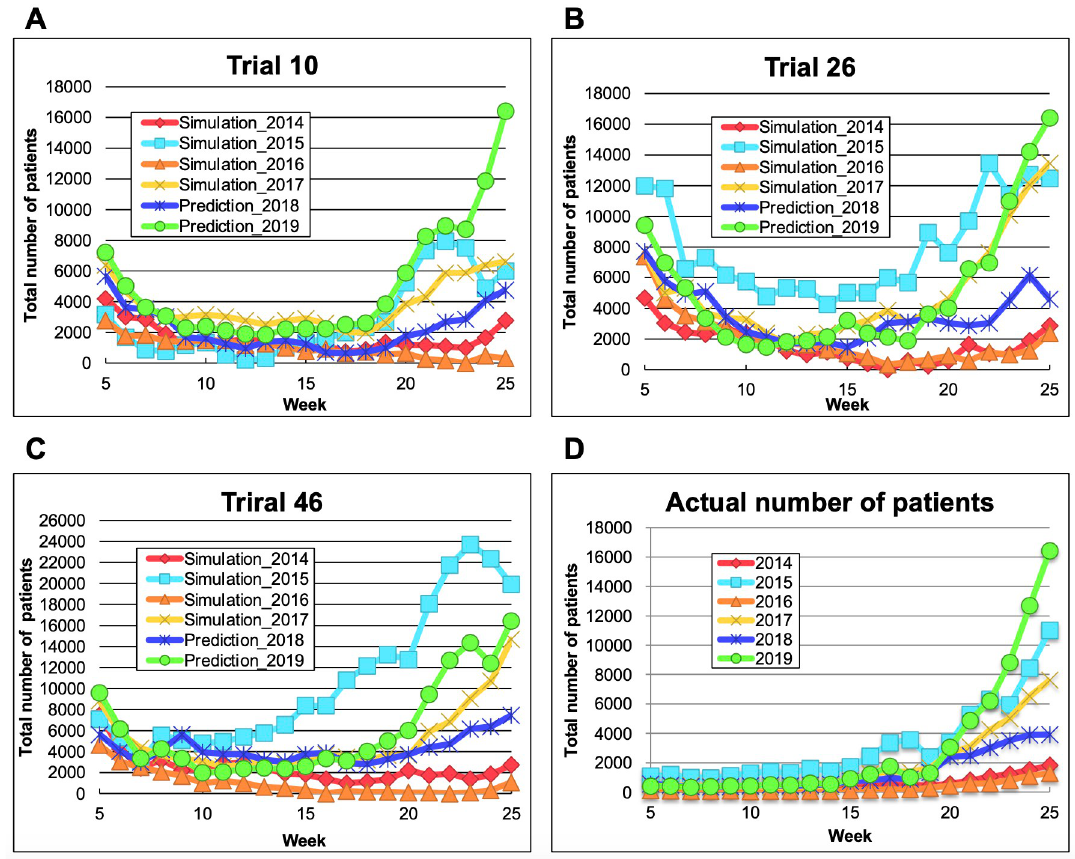
Fig 4. Epidemic patterns in 2018 and 2019 predicted by the three independently trained models (in trials 10, 26, and 46). (A–C): The maximum output value in 2019 and the minimum output value in 2014–2019 were adjusted to the maximum number of patients in 2019 and 0, respectively; (D) Actual numbers of patients until week